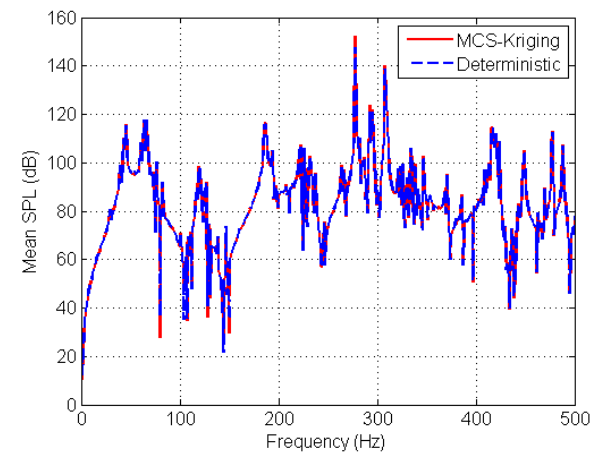
Figure 13. Variation of the SPL mean with the